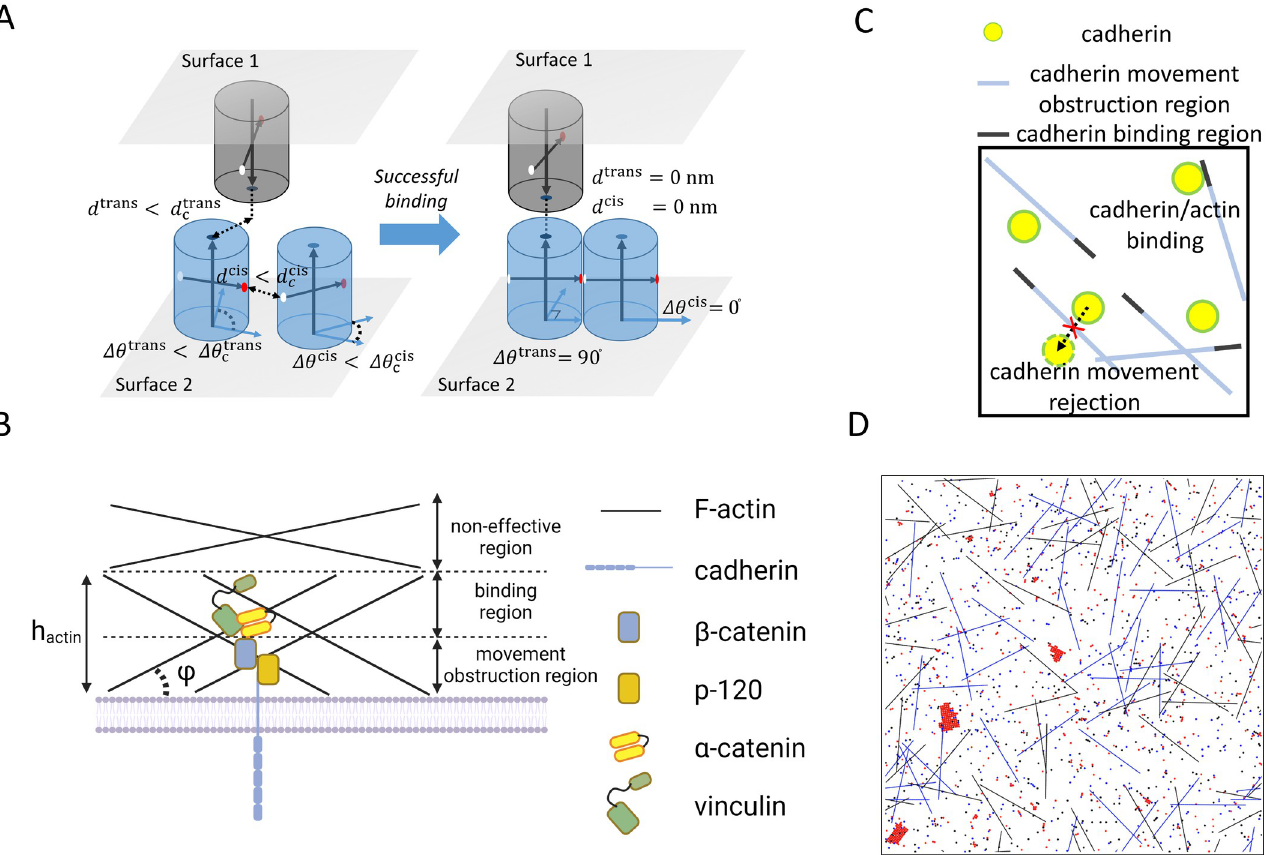
Fig 1. Coarse-grained model for studying cadherin clustering. (A) The intercellular junction is represented by two flat surfaces. The extracellular region of cadherin is simplified as a cylindrical column with 2.5 nm in radius. The trans binding site is located at a center point on the end of the column (dark blue dots). Donor (red dots) and receptor (white dots) sites for cis interactions are located on opposite sides of the lateral surface of the column. The locations of the donor and receptor sites define the orientation of cadherins, θ (horizontal arrows). For consideration of trans and cis interactions between two cadherin monomers, a distance between their axes, d , and a difference in their orientations, Δ θ , are measured. Interactions between two monomers take place if they satisfy two conditions for a distance ( d < d c ) and an angle ( Δ θ < Δ θ c ), where the subscript “c” indicates threshold values. After association, structural adjustment is performed; after trans interactions, the locations of two cadherin monomers are adjusted to make their axes align. After cis interactions, two monomers are slightly relocated to make the distance between their axes equal to the diameter of the columns, and their orientations are synchronized. (B) To simplify three- dimensional actin cortex beneath a membrane, we split the cortex to 3 different regions based on their distance from the membrane: cadherin movement obstruction region, cadherin binding region, and non-effective region. The non-effective region is not considered in our model. (C) Two-dimensional projection of the cadherin movement obstruction region and cadherin binding region. Part of F-actins that belongs to the movement obstruction region limits movement of cadherin monomers by rejecting their movement. Part of F-actins that belongs to the binding region can bind to cadherin monomers if they are sufficiently close to each other. After binding, cadherin monomers stop moving. (D) An example simulation with 1 μ m × 1 μ m area and periodic boundaries. Red dots represent trans dimers, and blue and black dots represent cadherin monomers located on the two surfaces shown in (A). Blue and black line segments represent F-actins located on two